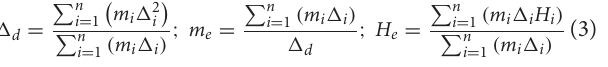
Frontiers in Built Environment |